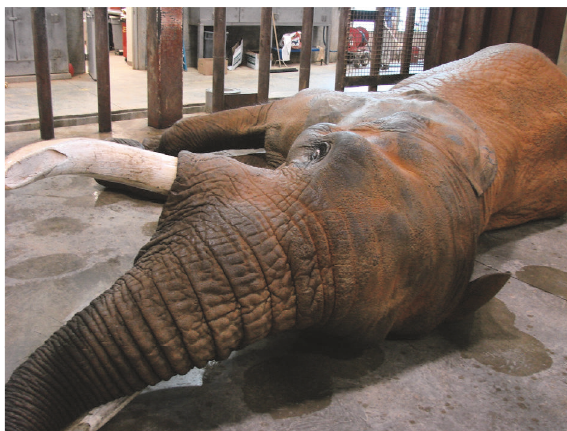
Figure 11: The elephant bull was photographed during a training session where he was practicing to lie down in left lateral recum- bency on command, with the hope that he would end up in the appropriatepositiontoperformphacoemulsificationofhisrighteye.